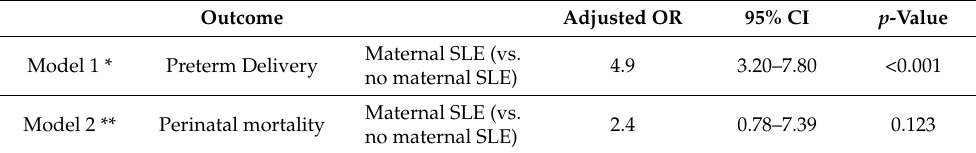
Table 3. GEE models for preterm delivery and perinatal mortality.